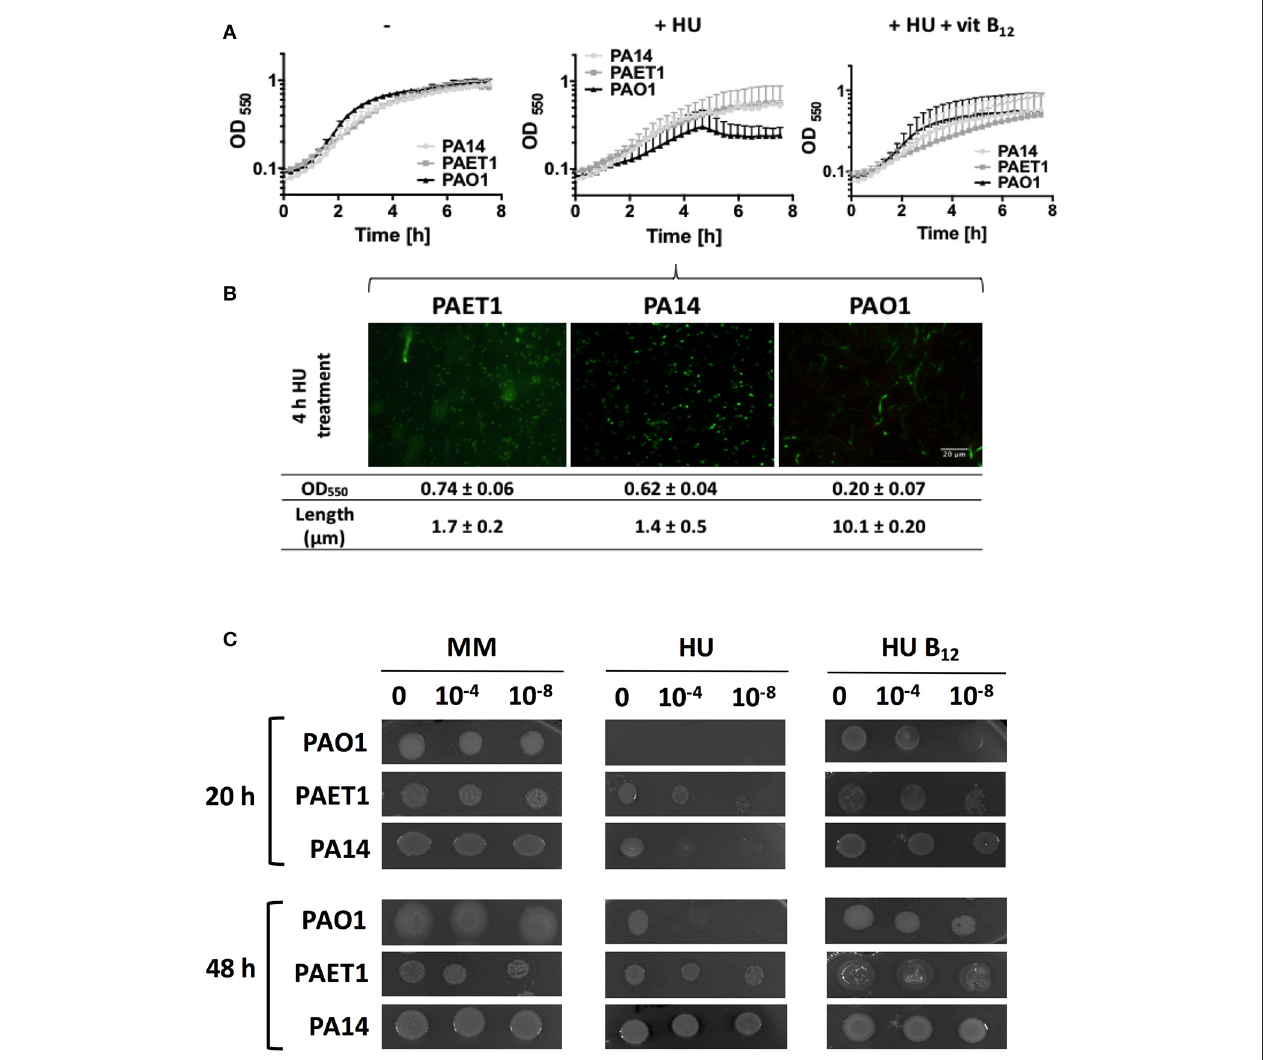
FIGURE 6 | P. aeruginosa PAET1 and PA14 strains are resistant to HU. (A) Growth curve of P. aeruginosa PAO1, PAET1 and PA14 strains in MM containing 30mM hydroxyurea (HU) and 1 µ g/ml vitamin B 12 . (B) Cells were visualized 4h after HU treatment. Images and values are representative of three independent experiments ± standard deviation. Bars represent 20 µ m. (C) Aerobic P. aeruginosa PAO1, PAET1 and PA14 strain cell viability with HU and vitamin B 12 at 20 or 48h of incubation. Pictures represent three independent experiments. Cultures were diluted to 0, − 4, and − 8 for the growth.